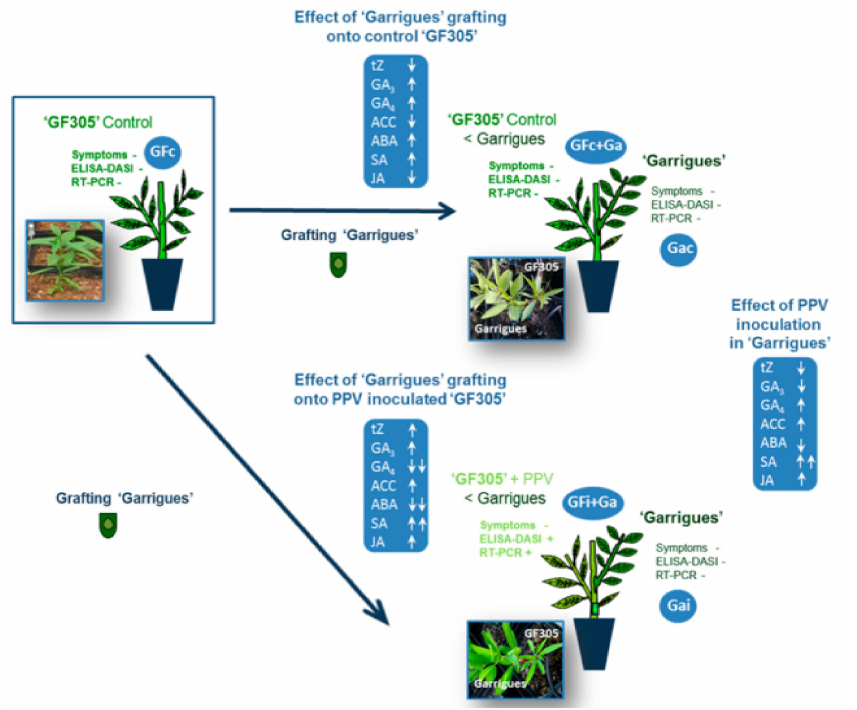
Figure 5. Summary of the differences observed in the production of hormones according to the different conditions (Control GF-305, Control GF-305 grafted with Garrigues, Infected GF-305 grafted with Garrigues, and Garrigues-infected). tZ: Cytokinin trans-zeatin; GA3 and GA4: Gibberelines; ACC: ethylene acid precursor 1-aminocyclopropane-1-carboxylic acid; SA: Salicylic acid; JA: Jasmonic acid; ABA: Abscisic acid. Adapted from Dehkordi et al.